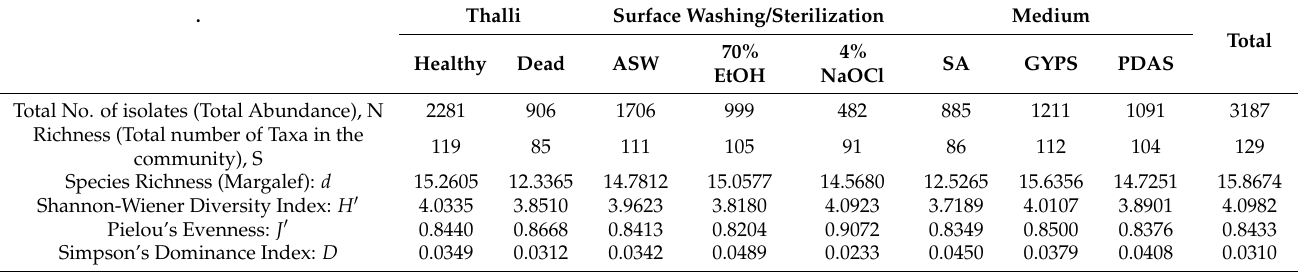
Table 1. Diversity indices of fungal communities isolated from healthy/dead thalli of Pterocladiella capillacea after surface washing/sterilization by artificial seawater (ASW), 70% ethanol (70% EtOH), and 4% sodium hypochlorite (4% NaOCl) plated on seawater agar (SA), glucose-yeast extract-peptone seawater agar (GYPS), and potato dextrose seawater agar (PDAS). .